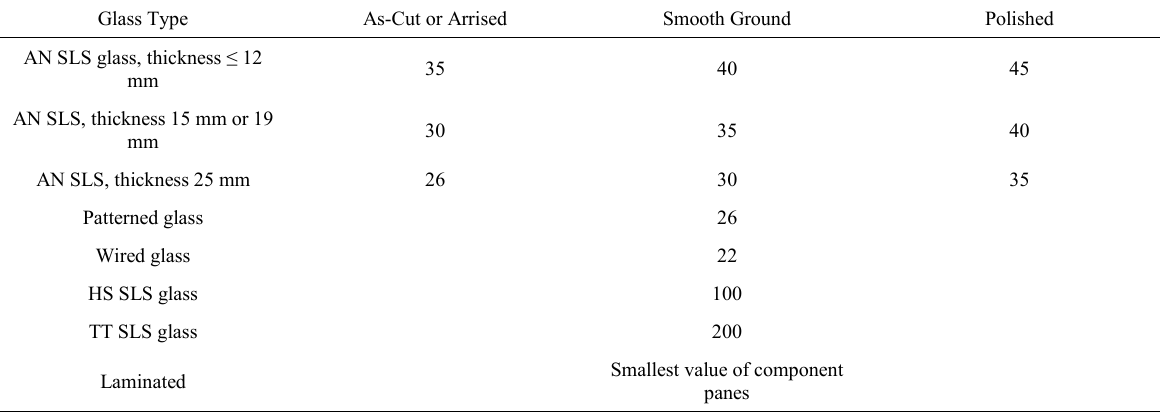
Table 2: Allowable temperature difference for different glass types with different edge finishings (Kozłowski et al. 2018). Glass Type